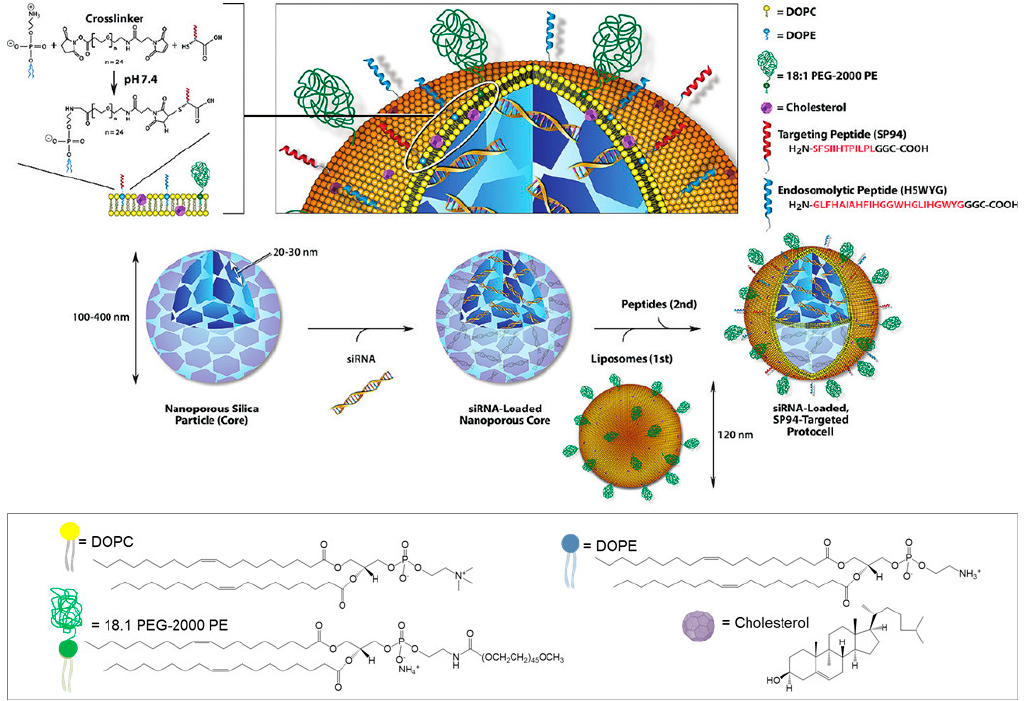
Figure 15. Schematic illustration of the synthesis of siRNA-loaded mesoporous silica nanoparticle-supported lipid bilayers (protocells). Reproduced from [106], with permission from American Chemical Society.